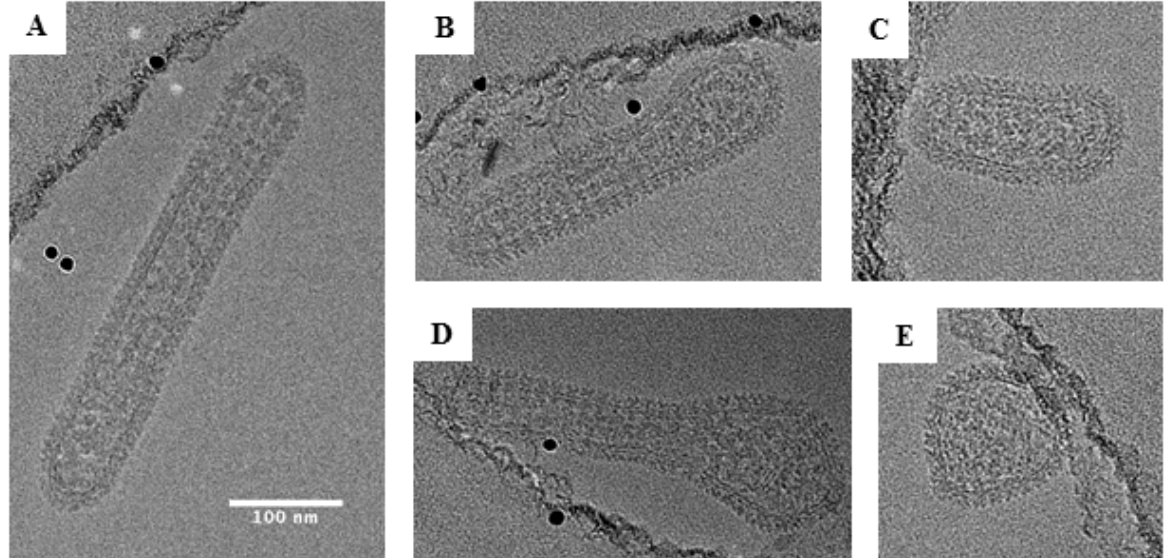
Figure 7. Representative cryo-EM images of Black Creek Canal virus. About 80% of the particles examined showed a tubular morphology as shown in panels ( A – C ). In panel ( D ), we show a representative image of an irregular virus particle. In panel ( E ), we show a representative image of a round virus particle. Scale bar: 100 nm.